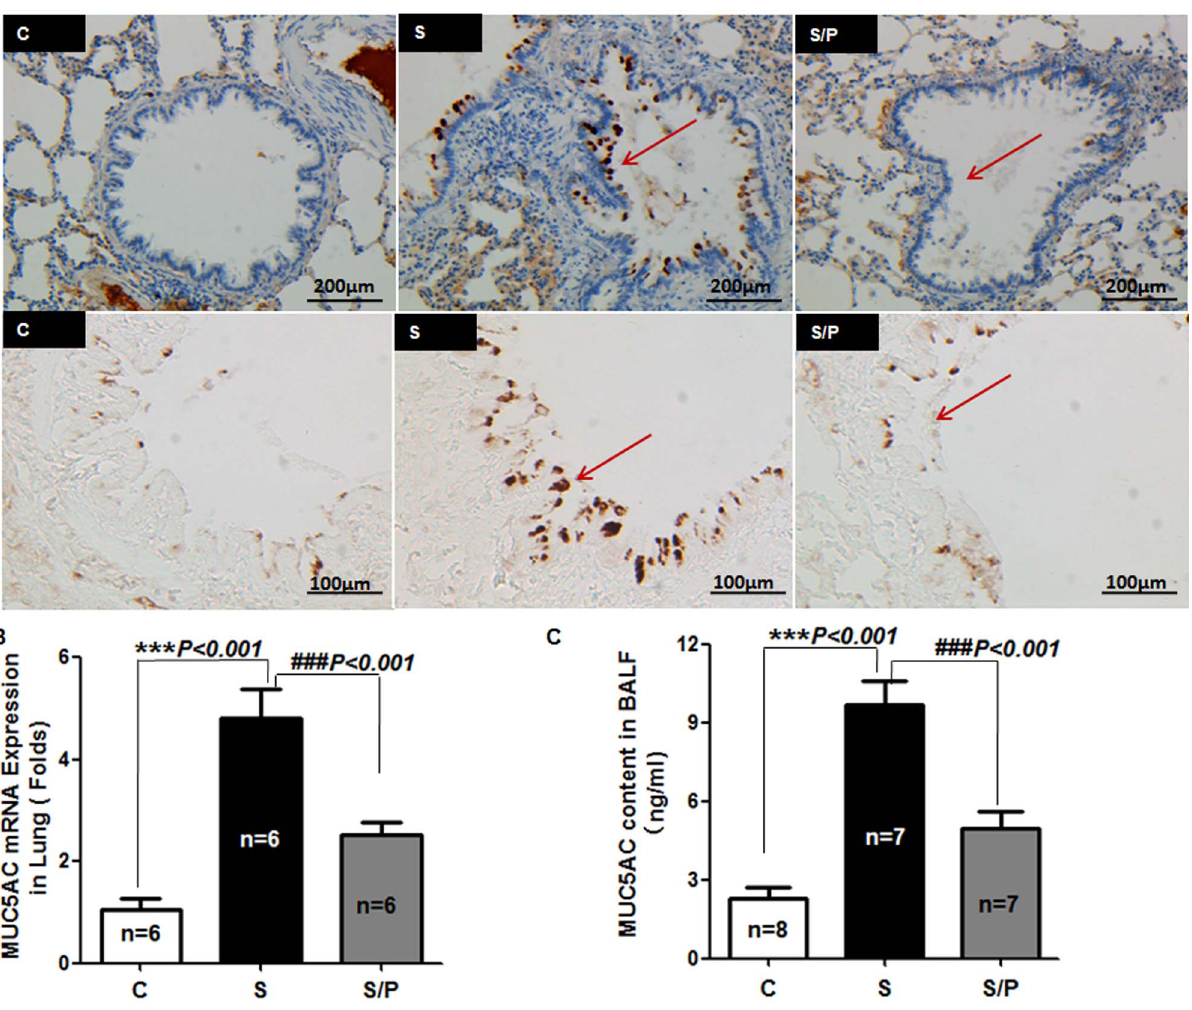
Figure 8. Chronic administration of propranolol decreases airway epithelial MUC5AC expression in rats exposed to CS. (A) MUC5AC glycoprotein expression in lung tissue by immunohistochemical staining. Bar=200 m m and 100 m m in the upper and lower images, respectively. (B) Quantitative RT-PCR analysis of mRNA level of MUC5AC in lung homogenate. (C) ELISA of MUC5AC protein in BALF. Data are means 6 SEM in each group.